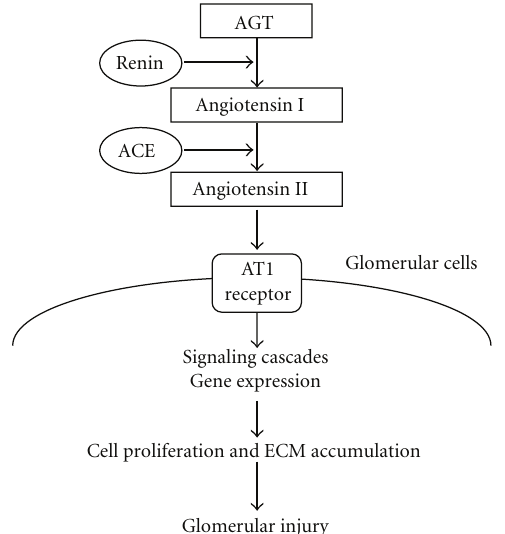
Figure 1: Working schematic of the renin-angiotensin system in glomerulonephritis. AGT: angiotensinogen, ACE: angiotensin- converting enzyme, AT1 receptor: angiotensin II type 1 receptor, and ECM: extracellular